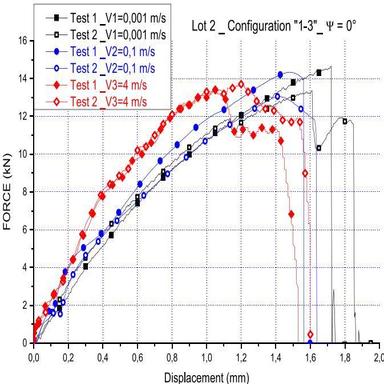
Loading velocity sensitivity under the pure opening load mode (ψ = 0∘ ) using SHTB system.